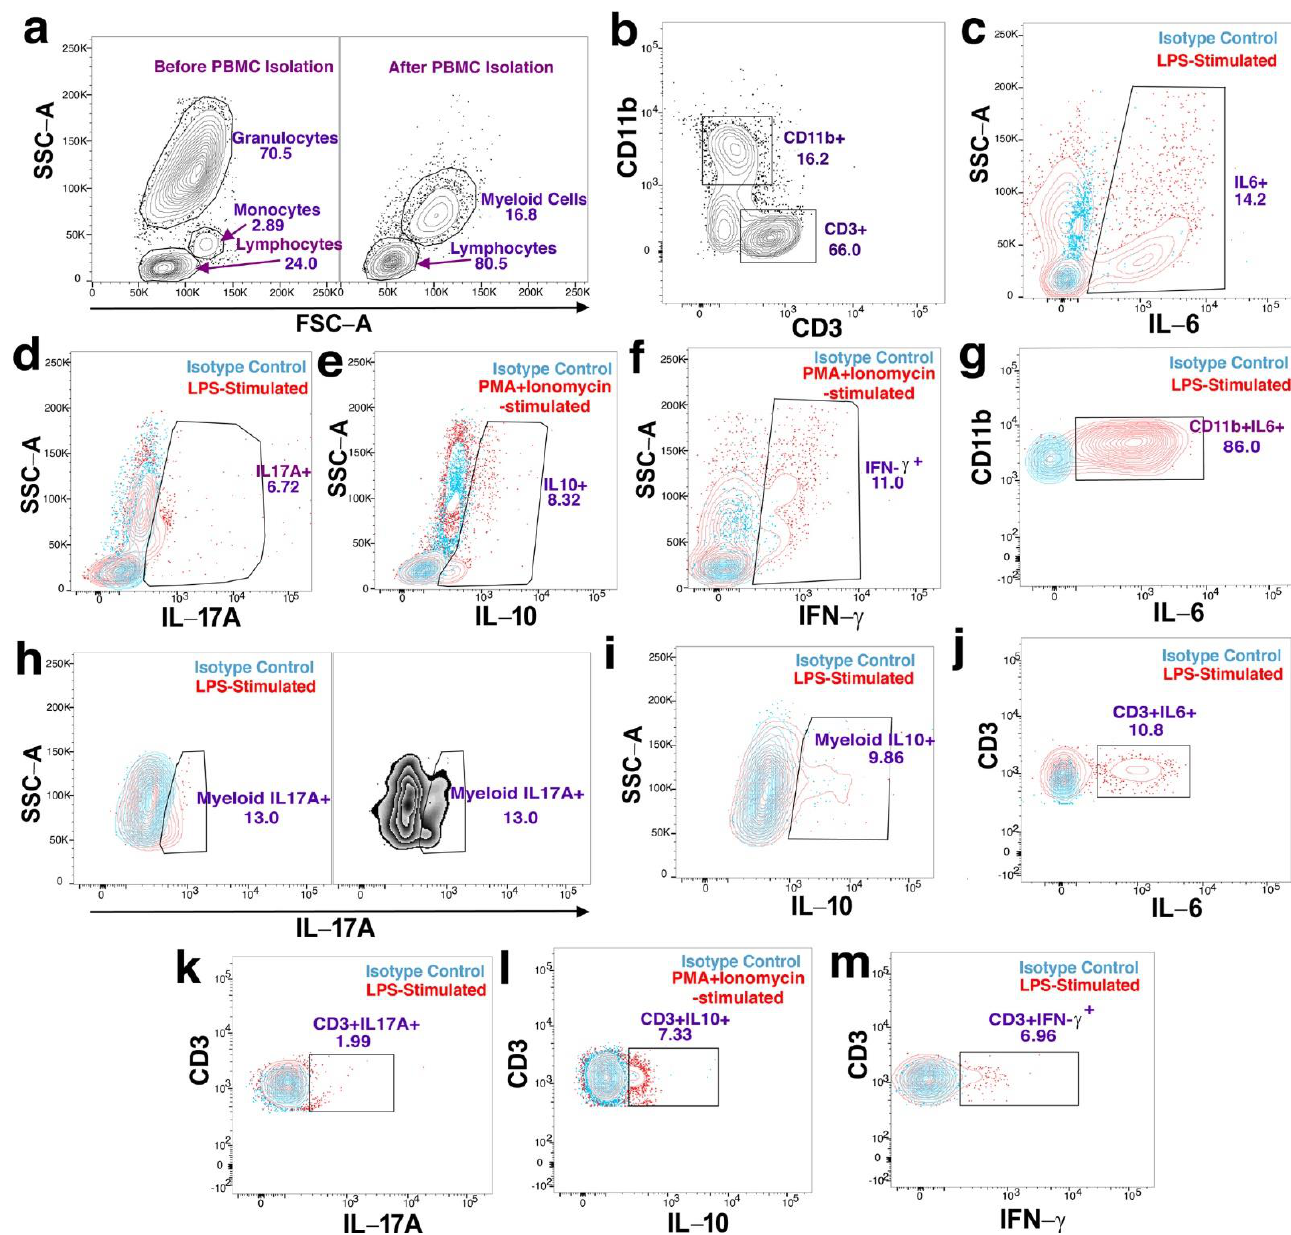
Figure 1. Gating strategies used in flow cytometry analysis to identify PBMC subsets and quantitate cytokine expression. ( a , b ) Representative data showing PBMC isolation and subsets: ( a ) Forward scatter (FSC − A) vs. side-scatter (SSC − A) plot of whole blood before (Left panel) and after PBMC isolation (Right panel), note absence of polymorphonuclear granulocytes. ( b ) CD3 vs. CD11b showing CD3 + and CD11b + PBMCs. ( c – f ) Representative data used to quantitate overall cytokine expression via cytokine vs. SSC −A plots to indicate the PBMC expression of: ( c ) IL-6; ( d ) IL-17A; ( e ) IL-10 and ( f ) IFN- γ. ( g – i ) Representative data used to quantitate cytokine expression in the CD11b + and myeloid cell subsets of PBMCs via cytokine vs. CD11b + or SSC −A plots: ( g ) IL-6; ( h ) IL-17A (Left panel shows myeloid cell IL-17A expression in contour display while right panel shows IL-17A expression without isotype control overlay in zebra display) and ( i ) IL-10. ( j – m ) Representative data used to quantitate cytokine expression in the CD3 + subsets of PBMCs via cytokine vs. CD3 plots: ( j ) IL-6; ( k ) IL-17A; ( l ) IL-10 and ( m ) IFN- γ. Populations in blue color have been stained with isotype controls while populations in red color have been stained with dye-conjugated antibodies. The gate frequencies displayed on plots are the percentages of events within each gate.